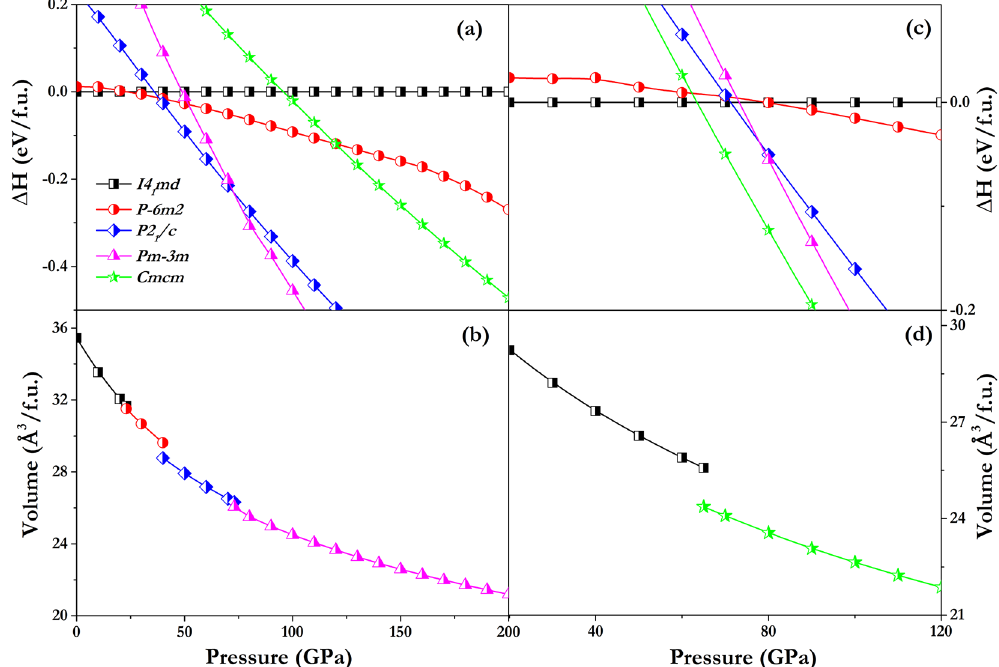
Figure 2. Calculated enthalpy difference per formula unit (f.u.) of different structures relative to the respective I 4 1 md ground-state structure and calculated volume per f.u. of the lowest-enthalpy phases as a function of pressure. (a , b) NbAs up to 200 GPa. (c,d) NbP up to 120 GPa for clarity.